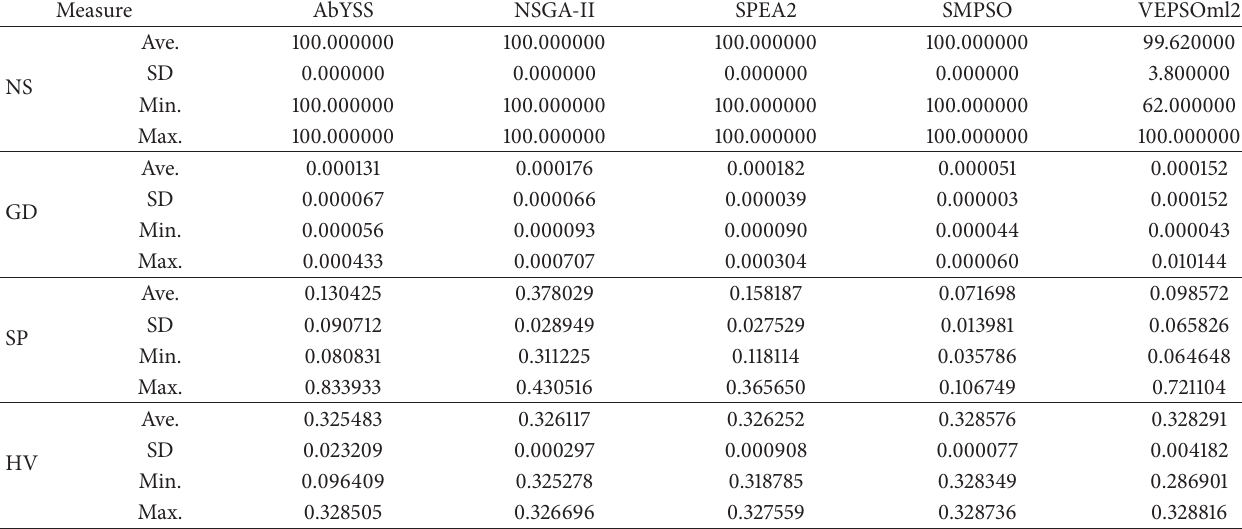
Table 8: Performance comparison based on ZDT2 test